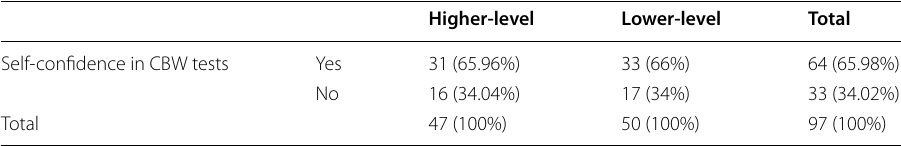
Table 3 A contingency table of the presence or absence of test-takers’ self-confidence in CBW tests across the